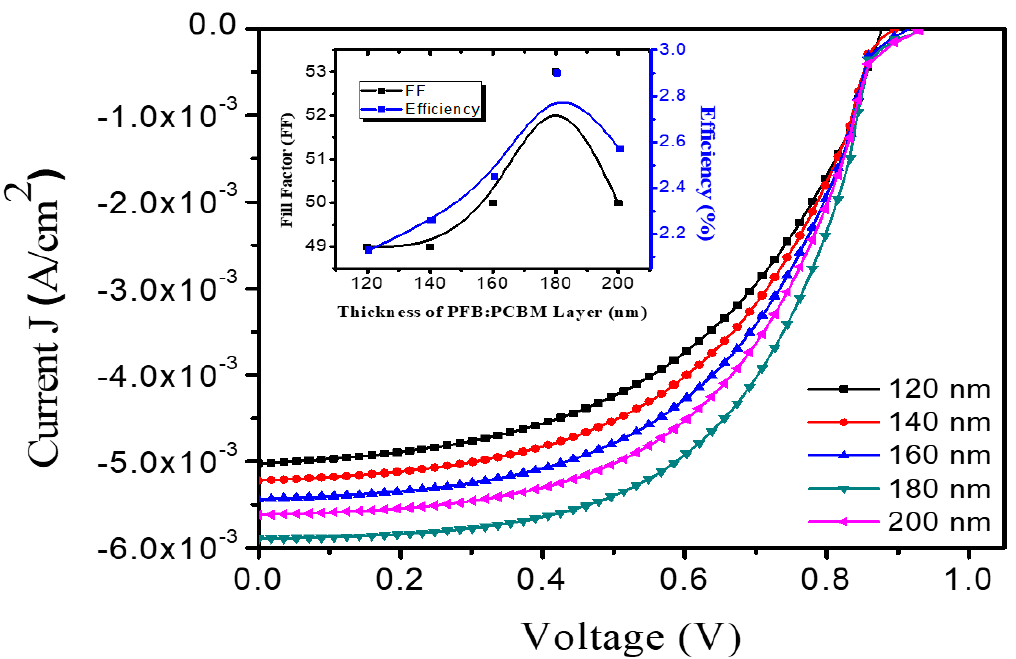
Figure 2. Current–voltage (I-V) characteristics of indium tin oxide (ITO)/ poly(3,4-ethylenedioxythiophene):poly(styrene sulfonate (PEDOT:PSS)/PFB–PCBM)/Ag BHJ solar cells of different thicknesses under illumination at standard testing conditions (STC) inset: active layer thickness vs. efficiency and fill factor (FF) graph. Table 1. Comparison of different parameters of the fabricated BHJ solar cells as a function of PFB– PCBM film thickness.